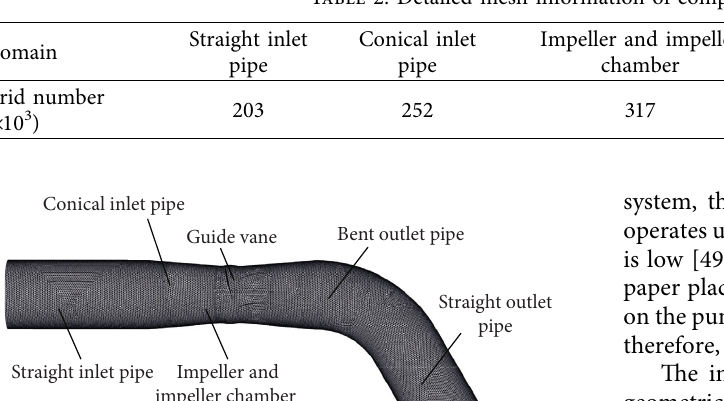
Table 2: Detailed mesh information of computational domain.